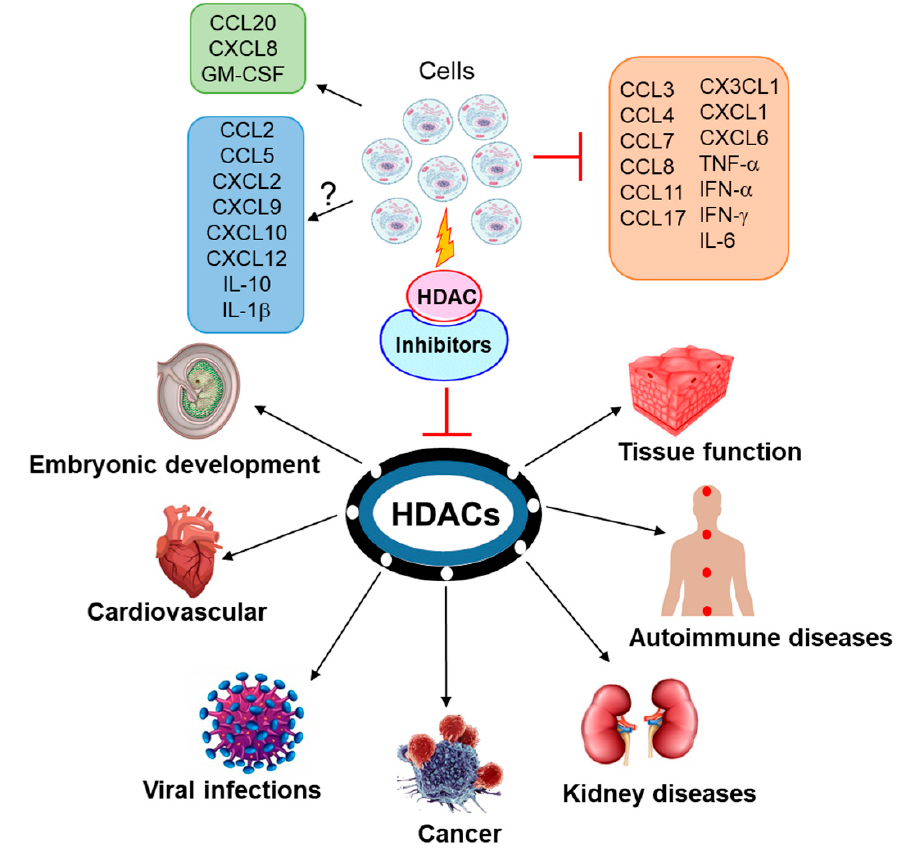
Figure 1. Regulation of chemokines and cytokines by histone deacetylases (HDACs) and HDAC inhibitors and implications of HDACs in various diseases. Cytokines, whose expression is inhibited on HDAC inhibition, are represented with red “T” bar. Cytokines, whose expression is induced on HDAC inhibition, are represented with black arrow. Cytokines with variable expression on HDAC inhibition are represented with an arrow and question mark.